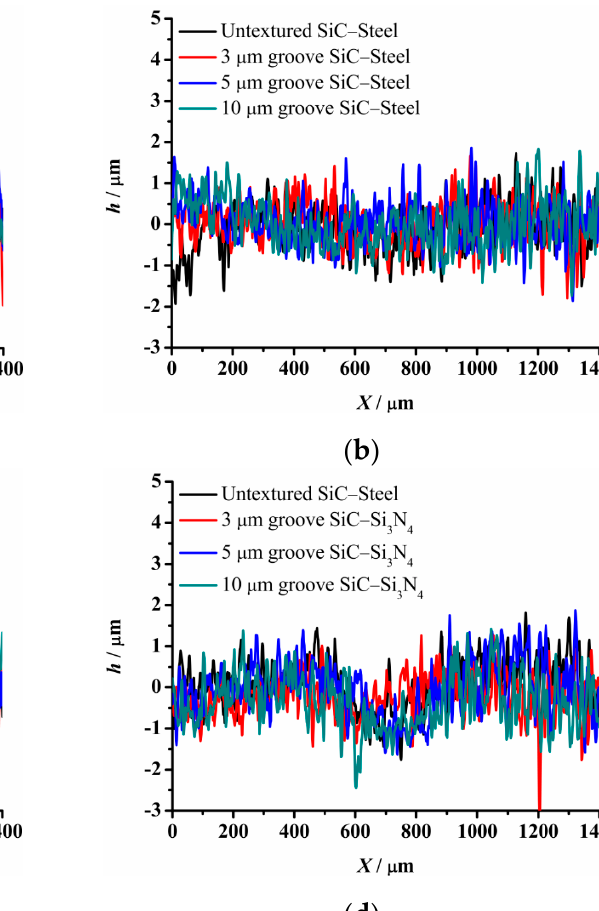
Figure 13. Wear performance of groove-textured SiC under oil-lubricated conditions with a load of 75 N (×10): ( a ) 3 μ m groove-textured SiC–steel ball, ( b ) 3 μ m groove-textured SiC–Si 3 N 4 ball, ( c ) 5 μ m groove-textured SiC–steel ball, ( d ) 5 μ m